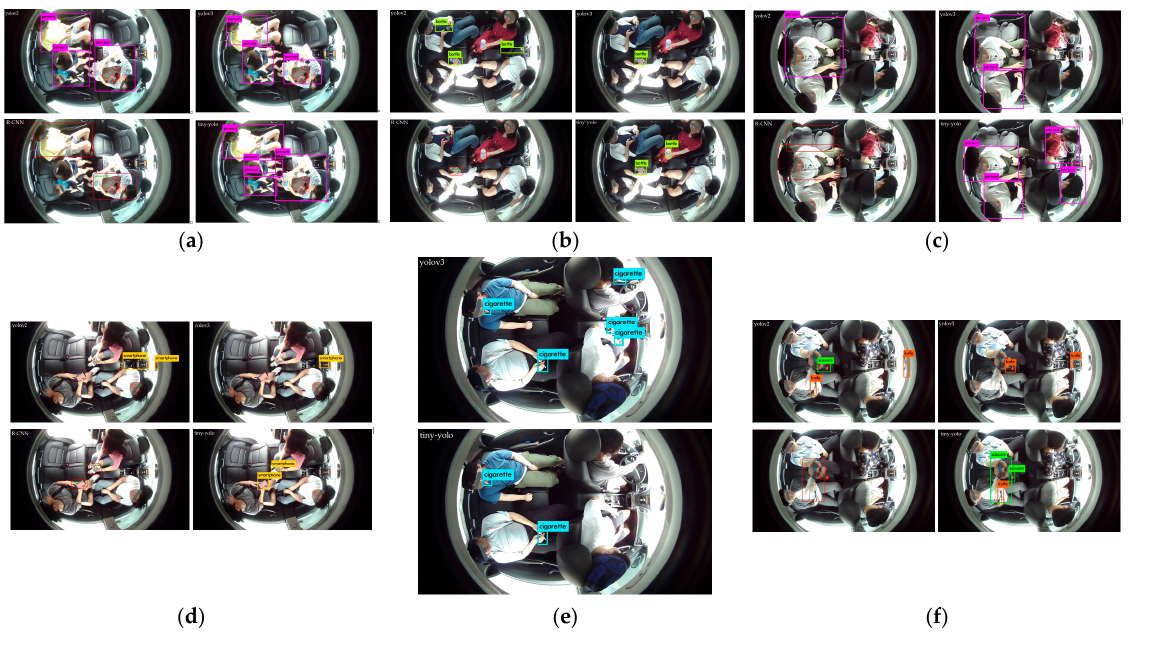
Figure 15. Performance comparison of object recognition using yolov2, yolov3, R-CNN, and tiny- yolo: ( a ) Occupancy; ( b ) Food and Beverages; ( c ) Occupants and Objects; ( d ) Cellular and Electronic Devices; ( e ) Smoking Items; ( f ) Harmful Objects. Table 5. A comparison of accuracy and inference time by different